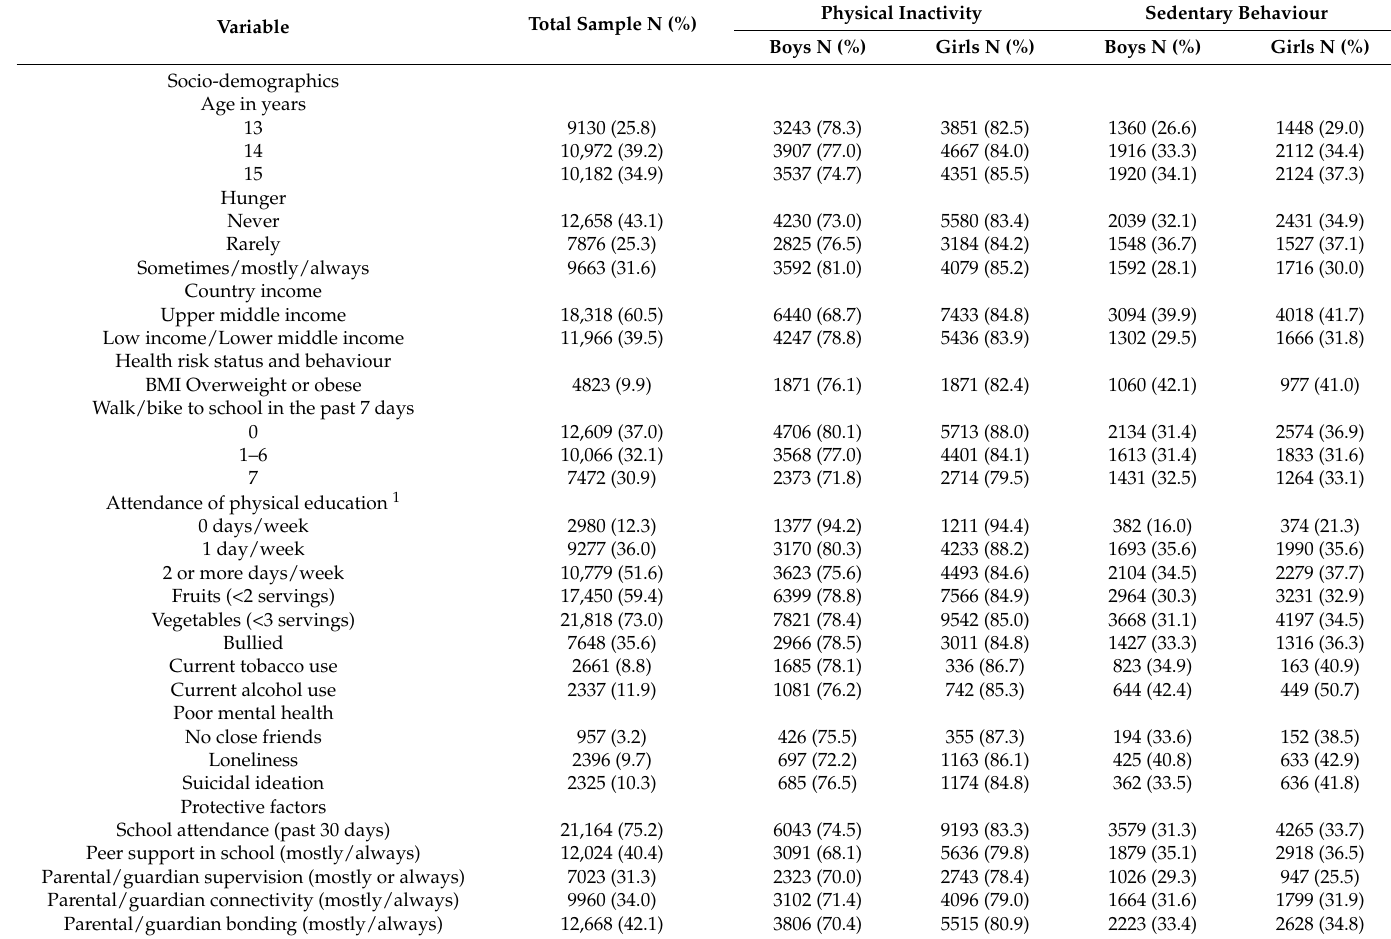
Table 4. Sample characteristics, physical inactivity and sedentary behaviour by independent